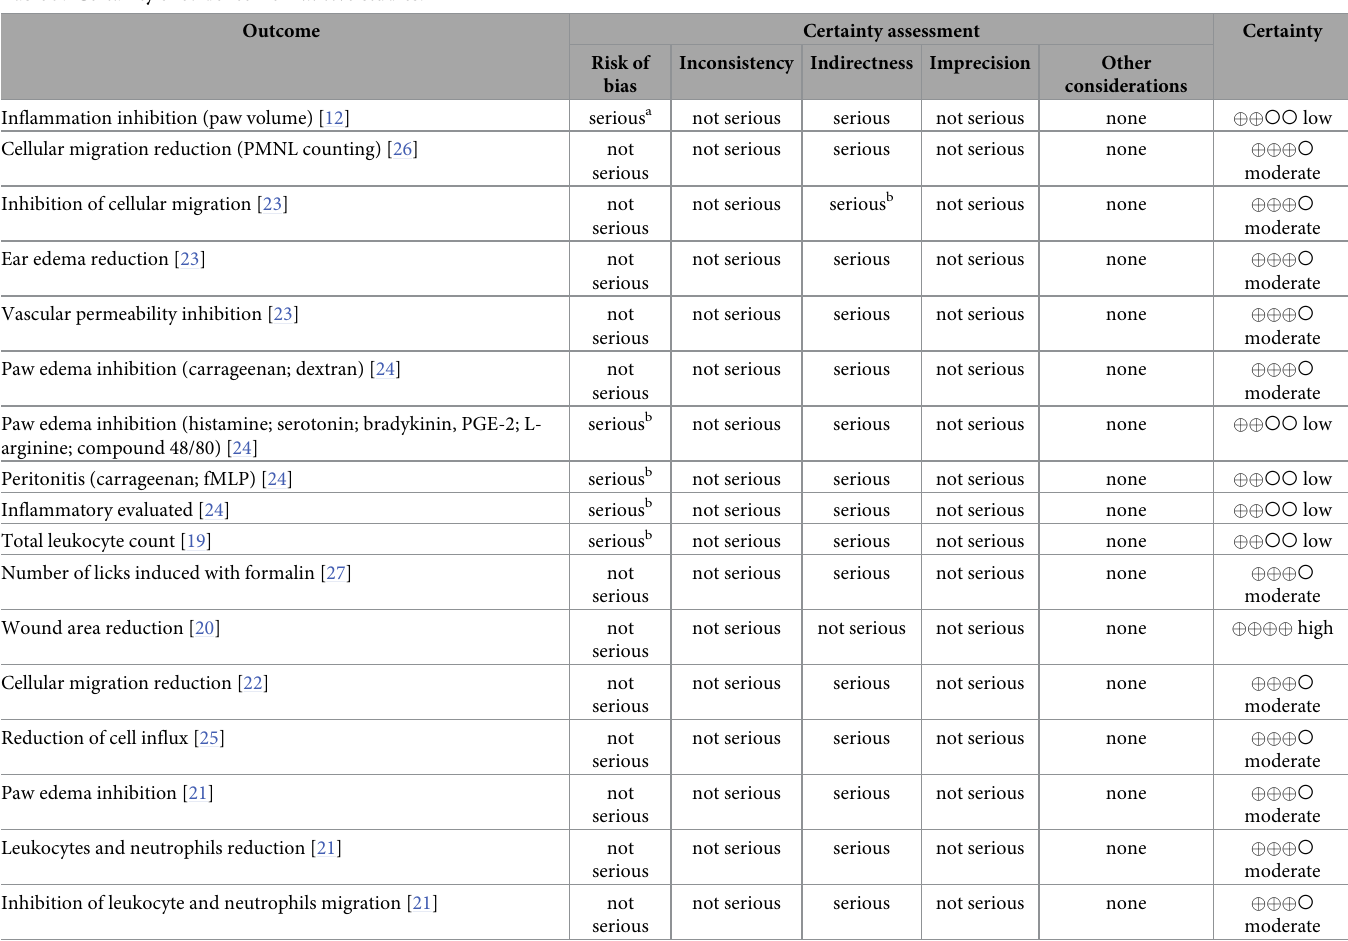
Table 7. Certainty of evidence from in vivo